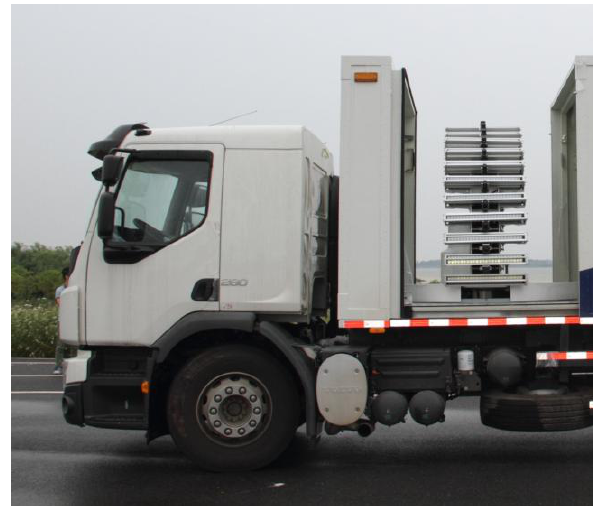
Figure 1a Lateral View of Camera and Reflector Array